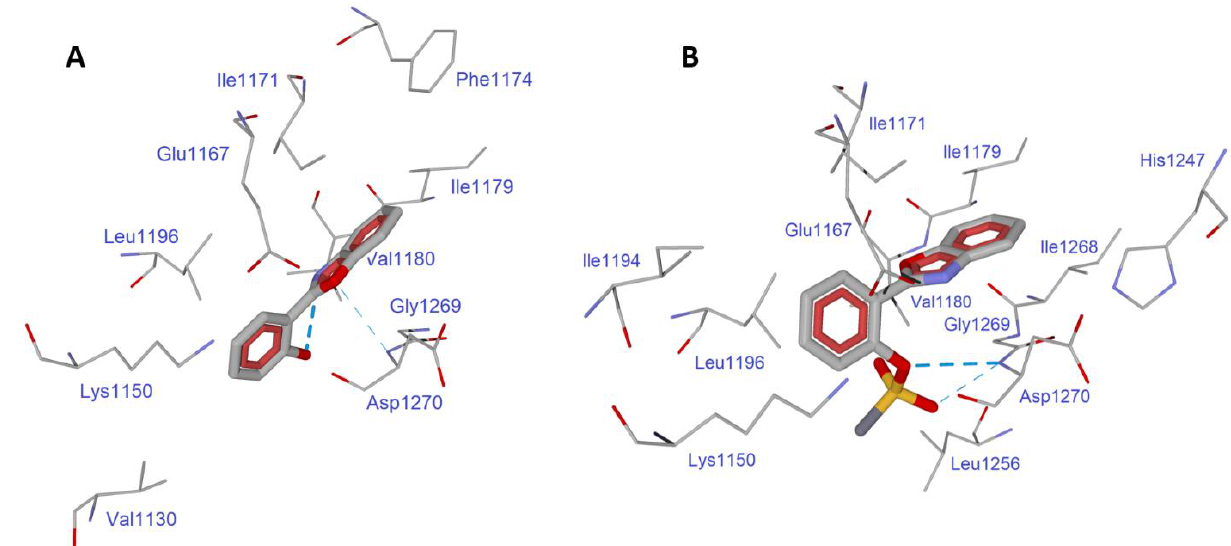
Figure 4. Docking poses of compounds 1 and 2 (Panels ( A , B ), respectively) in the binding site of R1275Q (PDB code 4FNY). Residues within 3 Å from each pose are visible. Hydrogen bonds are shown in blue dashed lines. The OH group of compound 1 forms an intramolecular H-bond with the benzoxazole nitrogen atom (Panel ( A )).